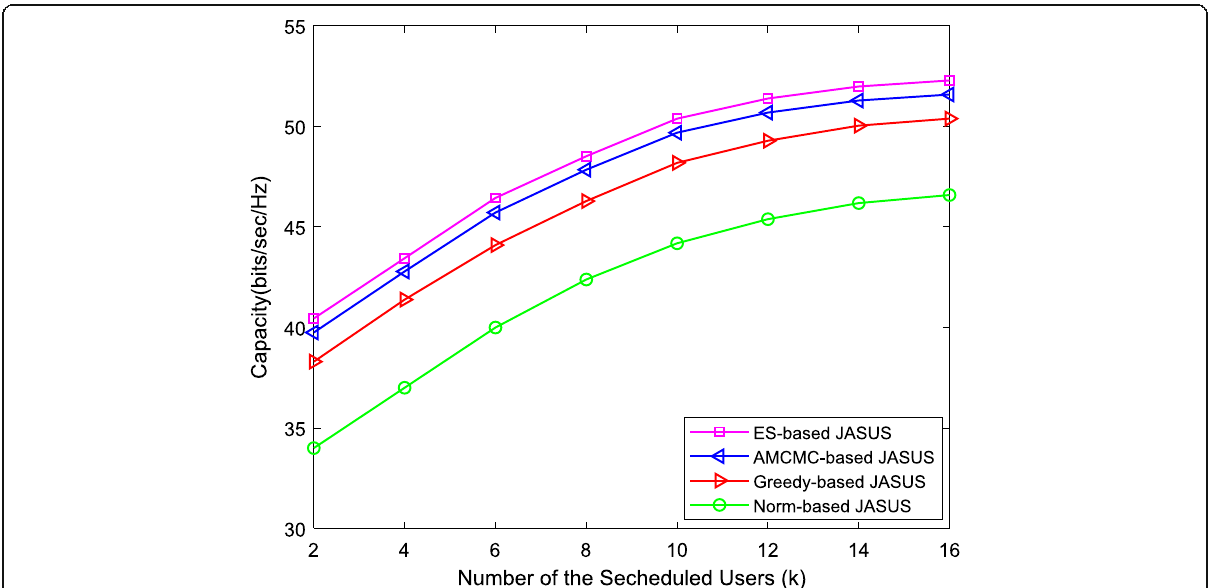
Fig. 7 Ergodic capacity of different algorithms with different scheduled number of users with B = 7, M = 64, U = 50, N = 16, and SINR = 20 dB